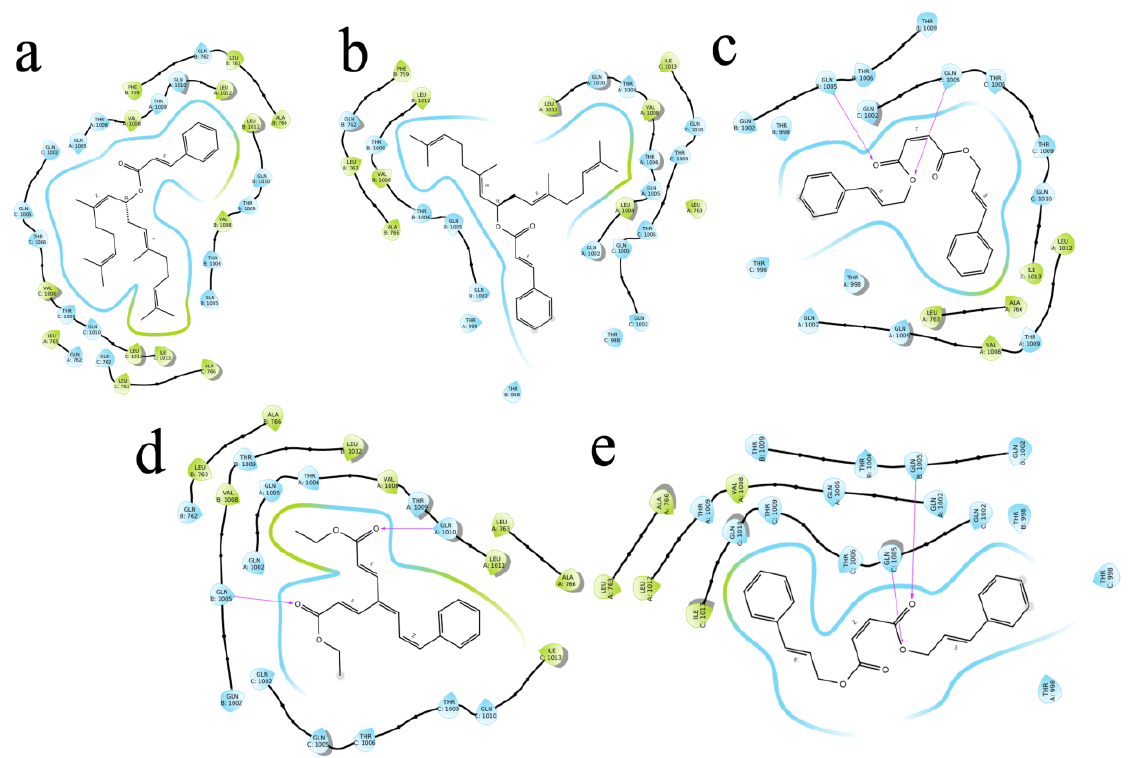
Figure 7. The 5 highest-ranked compounds with spike glycoprotein of their two-dimensional interactive diagram are represented as S1 ( a ), S2 ( b ), S3 ( c ), S4 ( d ), and S5 ( e ). Among the top 5 structures, epoxy-group side chains were highly interactive.